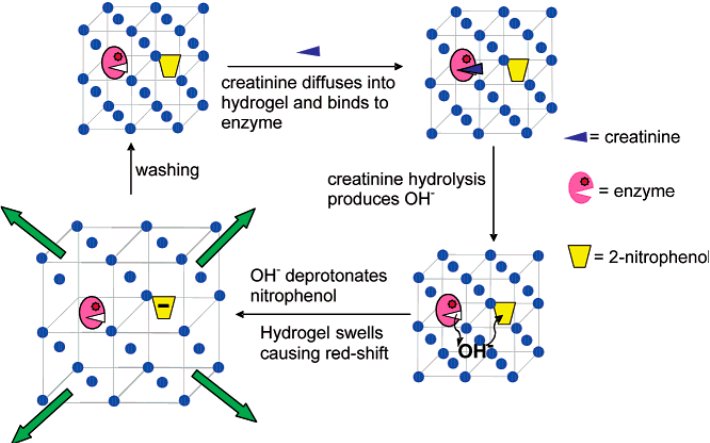
Figure 12. Schematic depiction of the creatinine sensor concept. Reproduced with permission from [39].